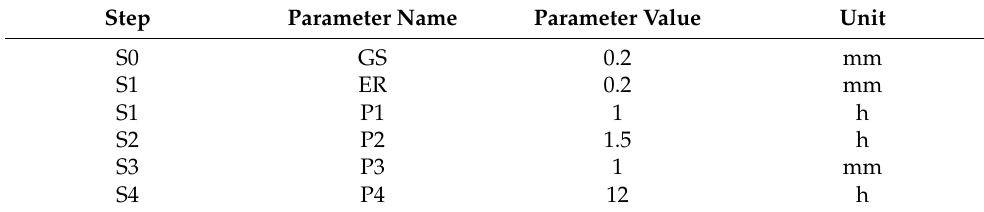
Table 1. The parameter values to reconstruct rainfall